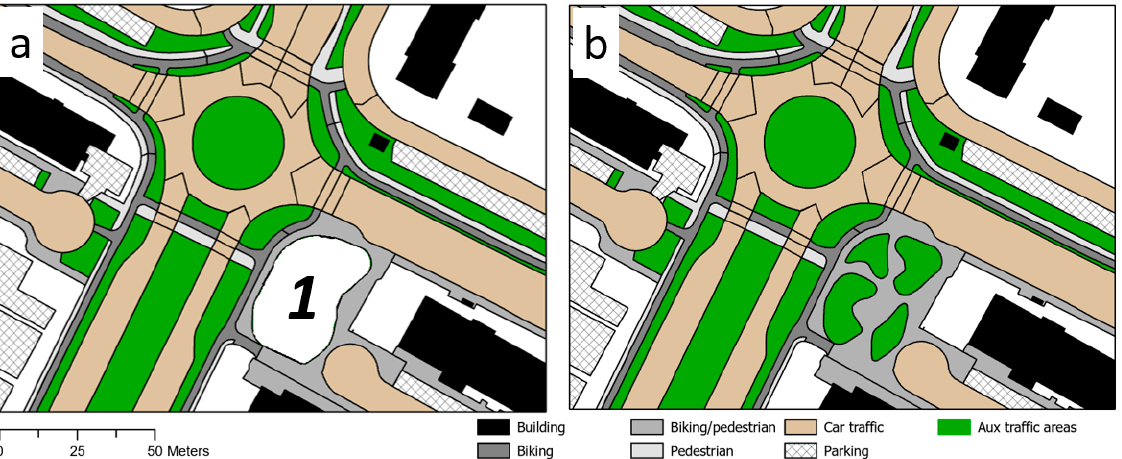
Figure 12. Transportation theme according to 3CIM, including both traffic areas and auxiliary traffic areas. Buildings are included for illustration purposes. The area “1” in panel ( a ) is modelled as transportation in ( b ).